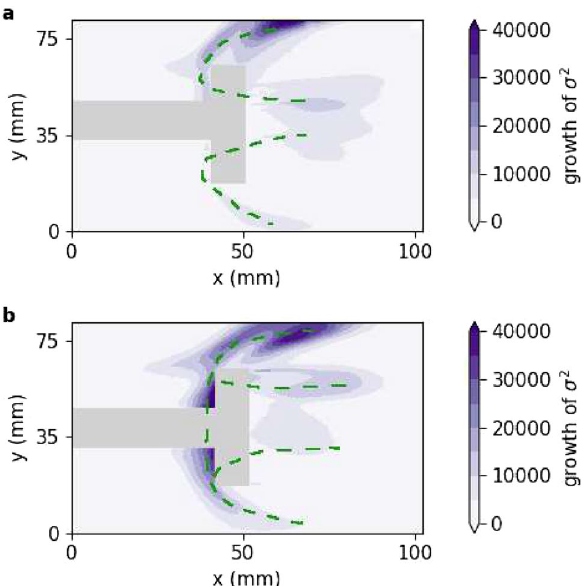
Figure 4. Growth of σ 2 of local heat release rate fluctuations between two values of the control parameter ˙ m air = 550 SLPM and 650 SLPM for experiments with ( a ) IS and ( b ) OS. For IS, growth of σ 2 is negligible at Z 2 while for OS, there is growth of σ 2 at Z 2 . Regions of high growth of σ 2 are highlighted using dashed green